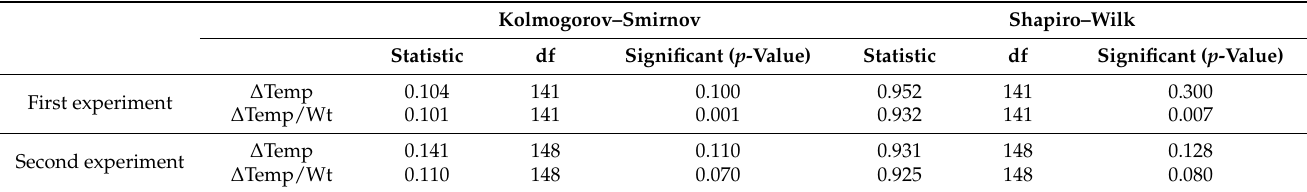
Table 5. Kolmogorov–Smirnov and Shapiro–Wilk test for ∆ Temp and ∆ Temp/Wt